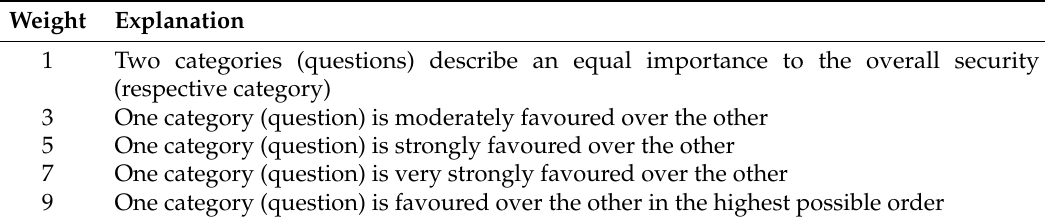
Table 8. Weights for Comparing Importance of Categories and